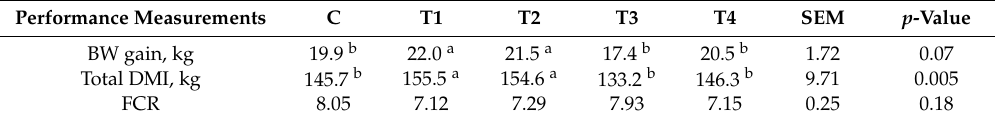
Table 2. E ff ect of dietary treatments on growth performance of lambs.